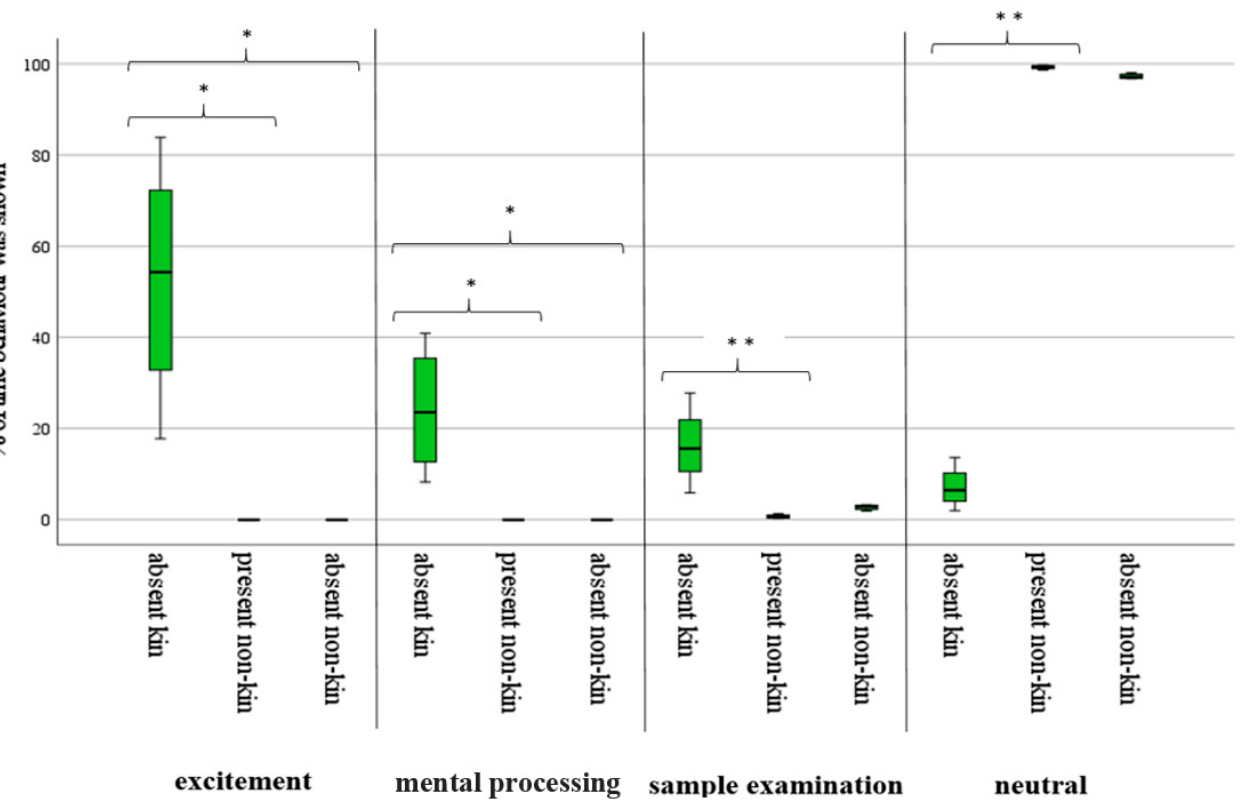
Figure 1. Reaction (in percentage of time) shown after confrontation with fecal samples (* p < 0.05; ** p < 0.01).